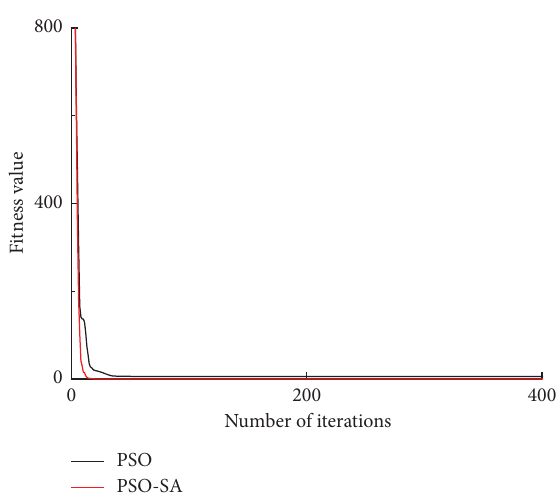
Figure 8: Comparison of detected and actual harmonics.